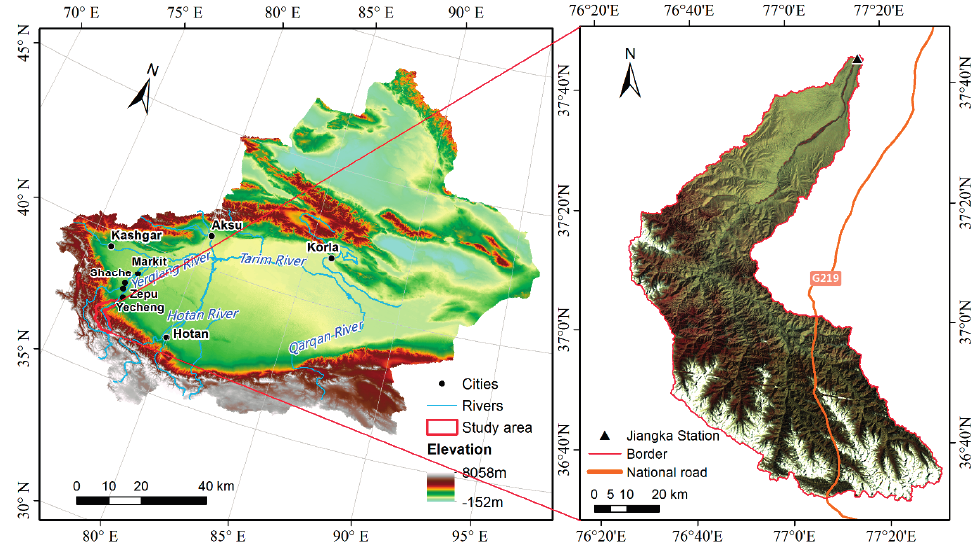
Figure 1. Location of the Tizinafu watershed in western China ( left ) and the Landsat TM image of 11 September 1976 showing snow cover within the watershed ( right